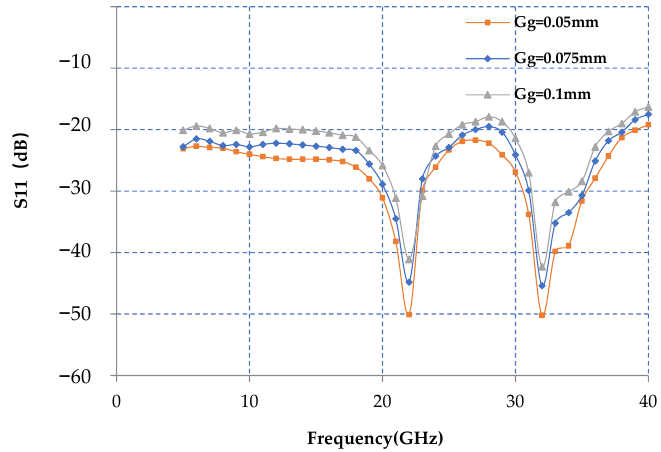
Figure 20. Tolerance analysis of the arch height of interconnected ribbon Gg.